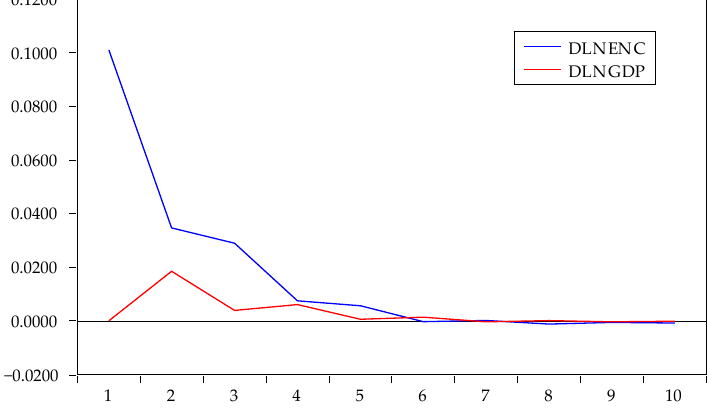
Figure 6. Impulse response of DLNFDI to DLNEC and DLNGDP.